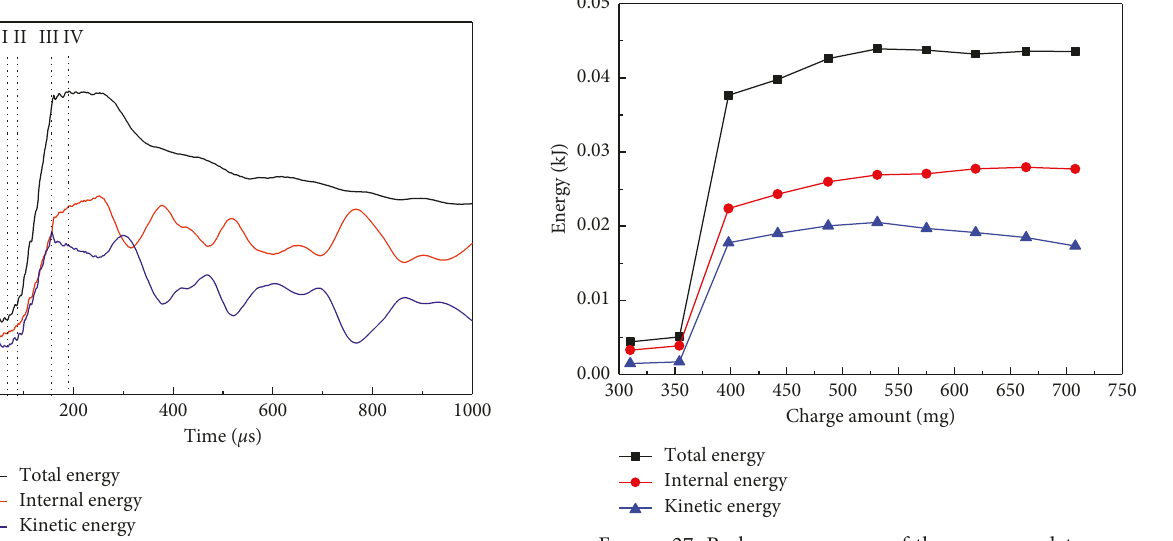
Figure 25: Energy histories of the response plate at 442 ° mg charge amount.